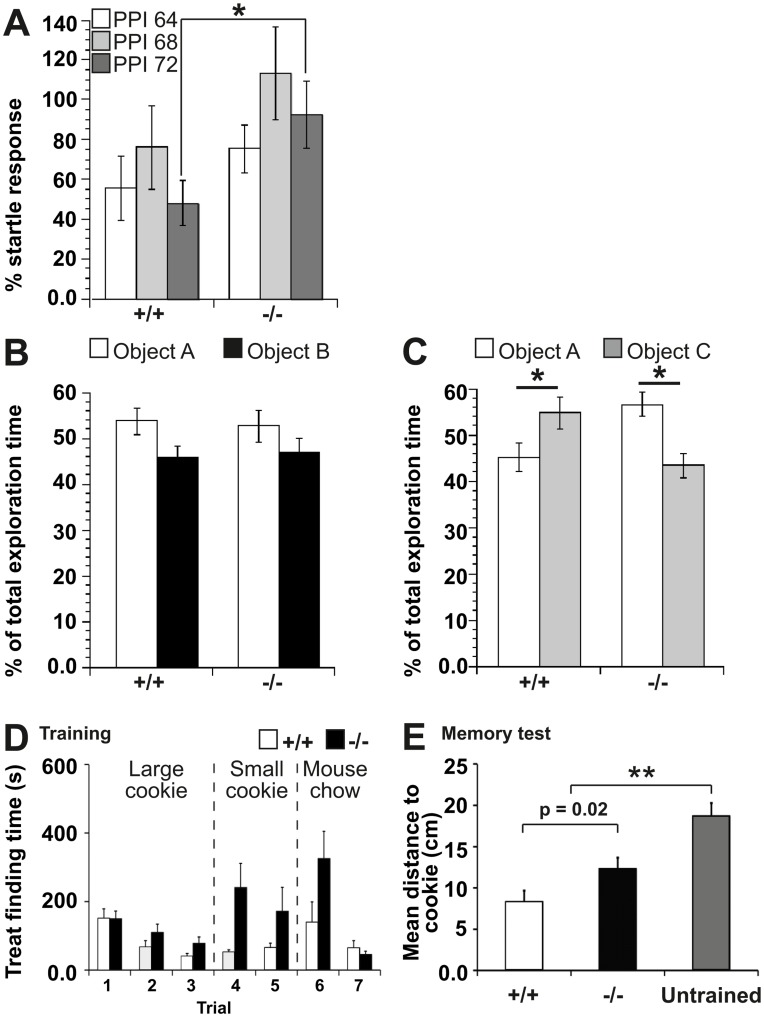
Upregulation of metabotropic glutamate receptor 4 in Panx1−/− mice.a, Volcano plot representing the expression of 84 genes relevant for synaptic plasticity (Panx1+/+/Panx1−/−, n = 4). b, Inhibition of grm4 by bath application of 100 µM UBP1112. Fifteen minutes post-HFS, UBP1112 induced impaired persistent LTP in Panx1−/−s. Panx1+/+-LTP steadily increased during the entire post-HFS period without reaching the level of untreated Panx1−/−s. Insets in (b) indicate Panx1−/− and Panx1+/+ original responses under blocking conditions before and 30 min post-HFS (scale horizontal: 10 ms, vertical: 0.5 mV). c, No differences were found for Panx1−/−s during the early LTP phase (0–5 min) compared to the ACSF treated Panx1−/−s. Persistent phase analysis reveals alignment of the fEPSP levels of both the UBP1112-treated +/+ and −/−. Statistics: (c) ANOVA (early: F3,64 = 637.1; P<0.0001; late: F3,64 = 105.9; P<0.0001).